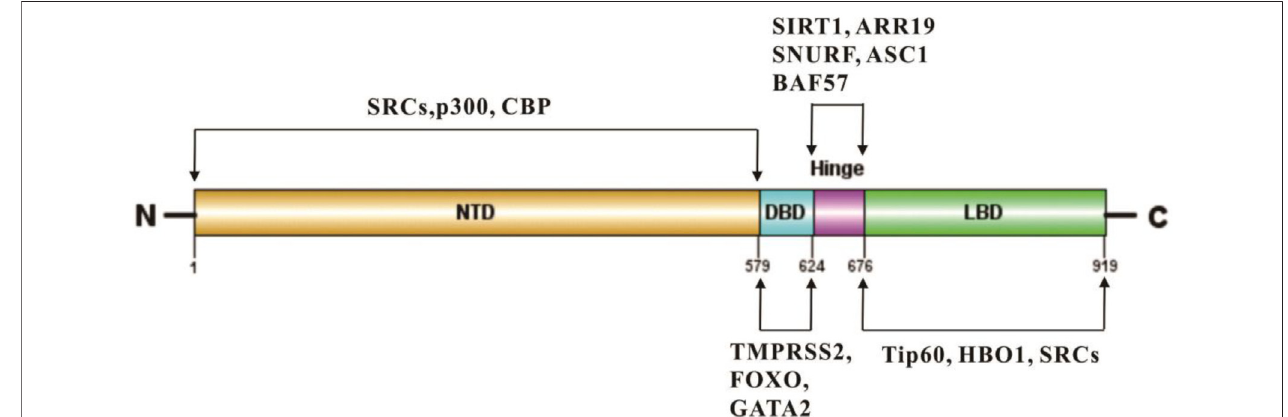
FIGURE 4 | Representative epigenetic regulators bind to multiple domains of AR protein.